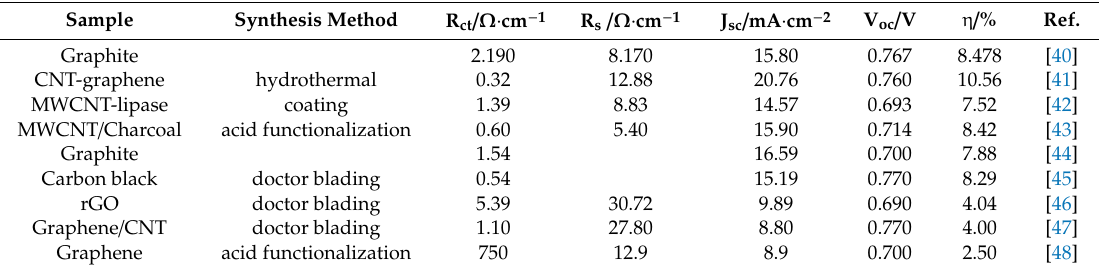
Table 3. Photovoltaic parameters for various carbon-based materials.